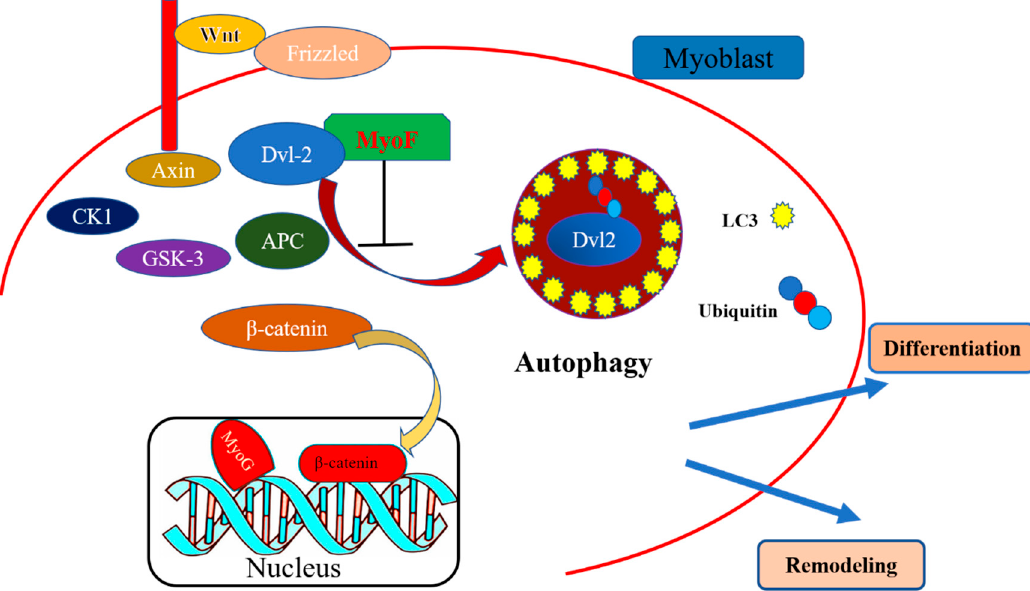
Figure 7. Model of the role of MyoF during skeletal muscle development. MyoF interacts with Dvl-2 to antagonize autophagy-mediated degradation, thereby activating the Wnt / β -catenin signaling pathway to regulate skeletal muscle development.